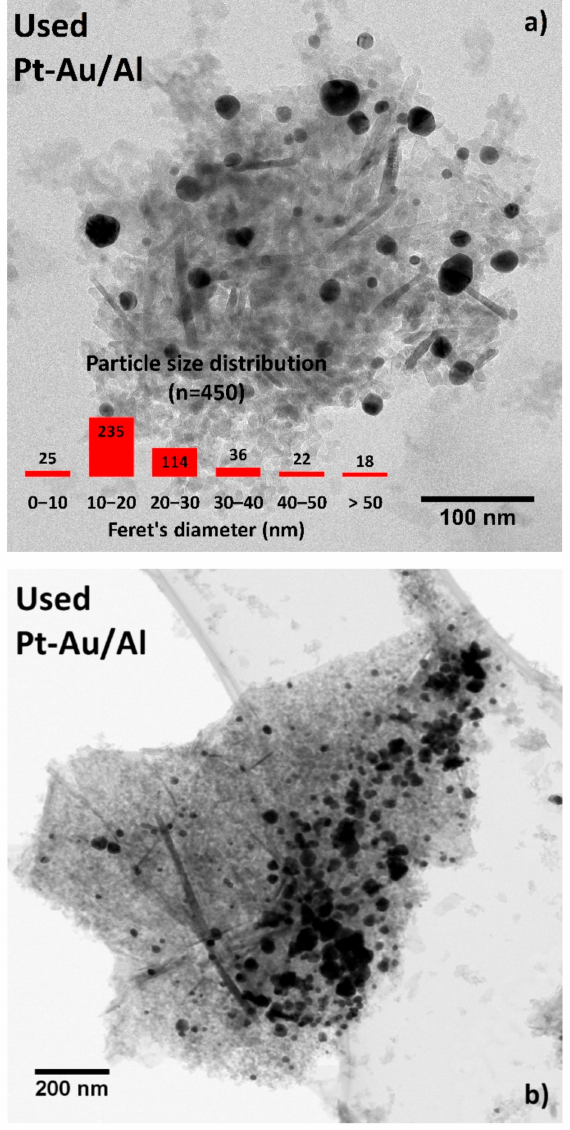
Figure 12. Representative ( a ) HR-TEM image with PSD data and ( b ) STEM image of the used Pt-Au / Al catalyst after the 100-h stability test in DCM oxidation (same conditions as in Figure